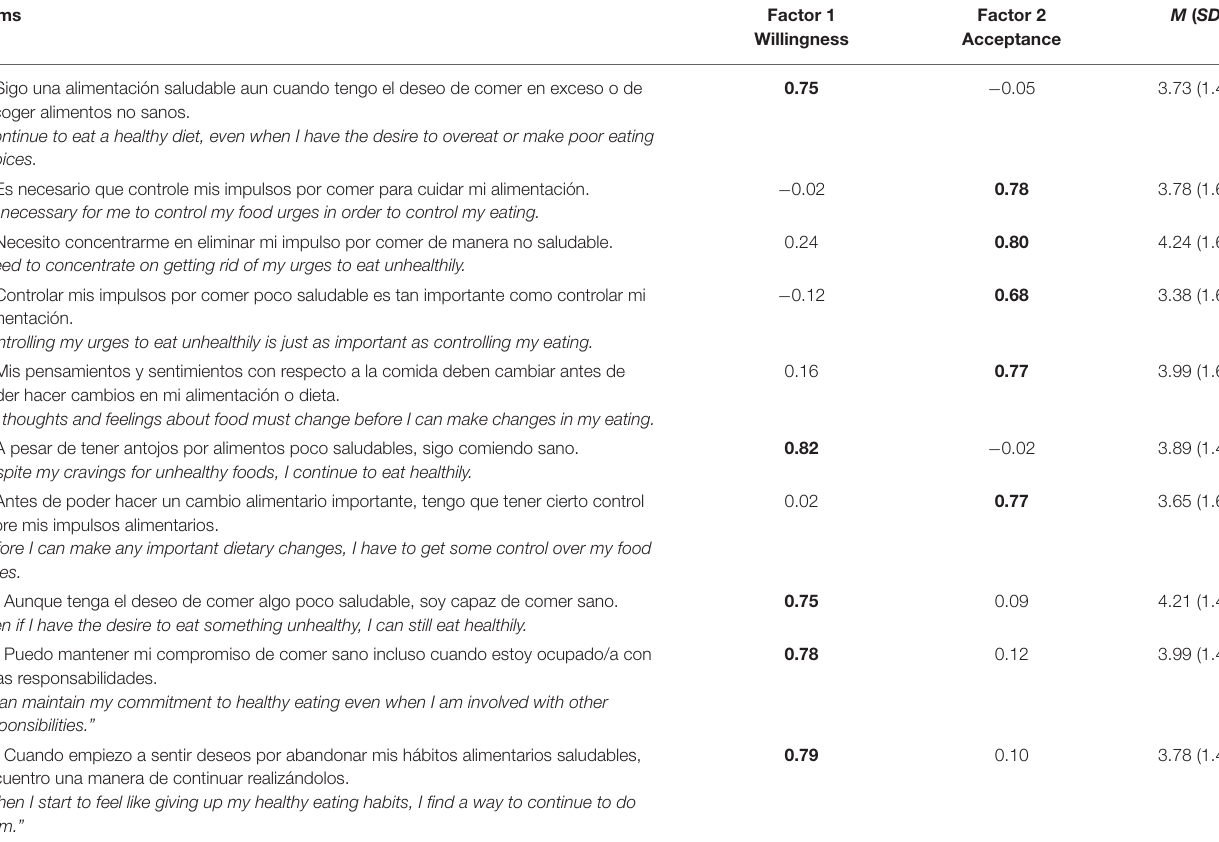
TABLE 3 | Exploratory factor analysis loadings and descriptive statistics of the refined version of the